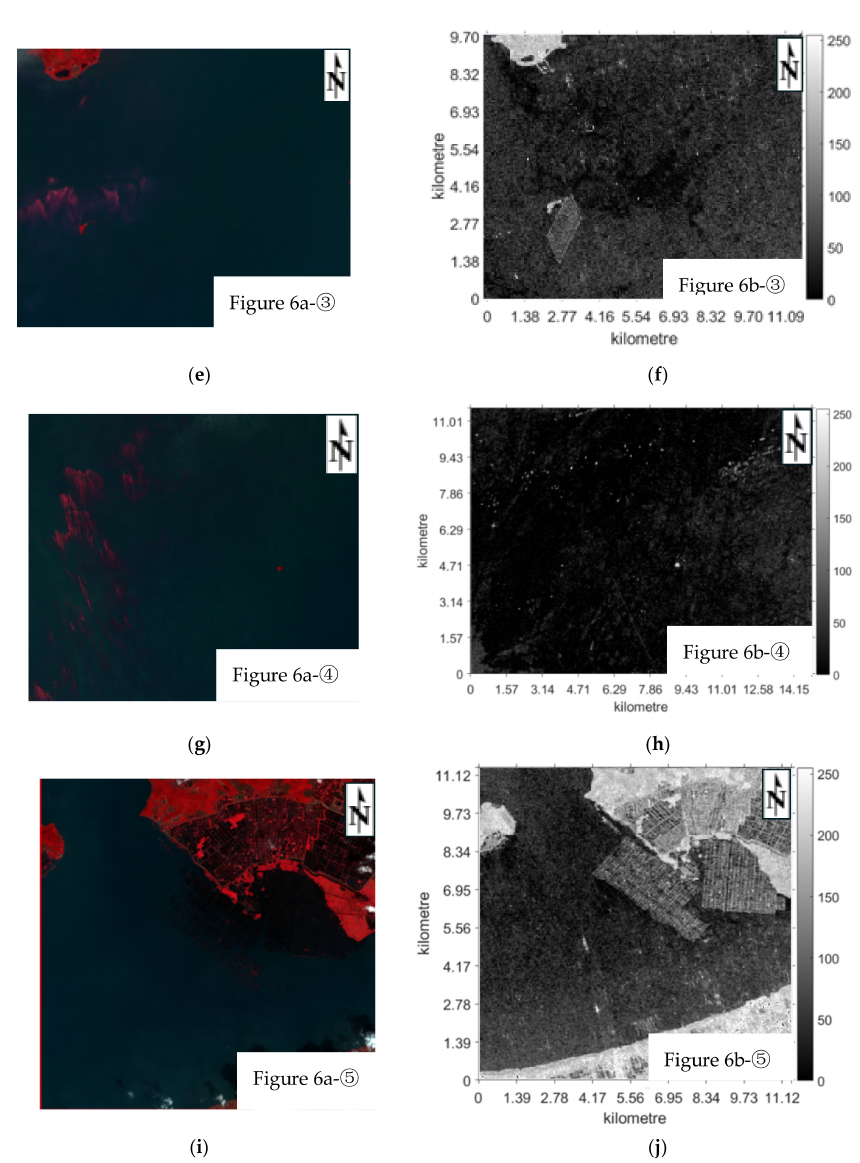
Figure 7. The zoomed area of Figure 6: ( a , b ) the zoomed image of region 1 (cid:13) in Figure 6a,b, respectively. ( c , d ) region 2 (cid:13) . ( e , f ) region 3 (cid:13) . ( g , h ) region 4 (cid:13) . ( i , j ) region 5 (cid:13)